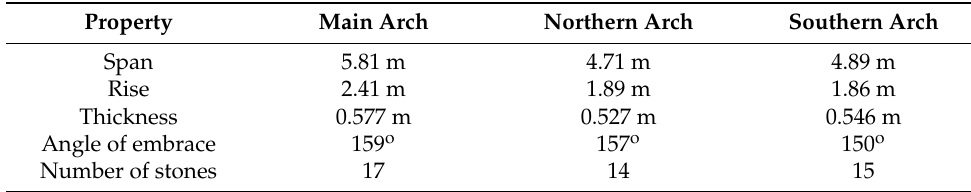
Table 1. Geometrical characterization of the case study bridge arches.